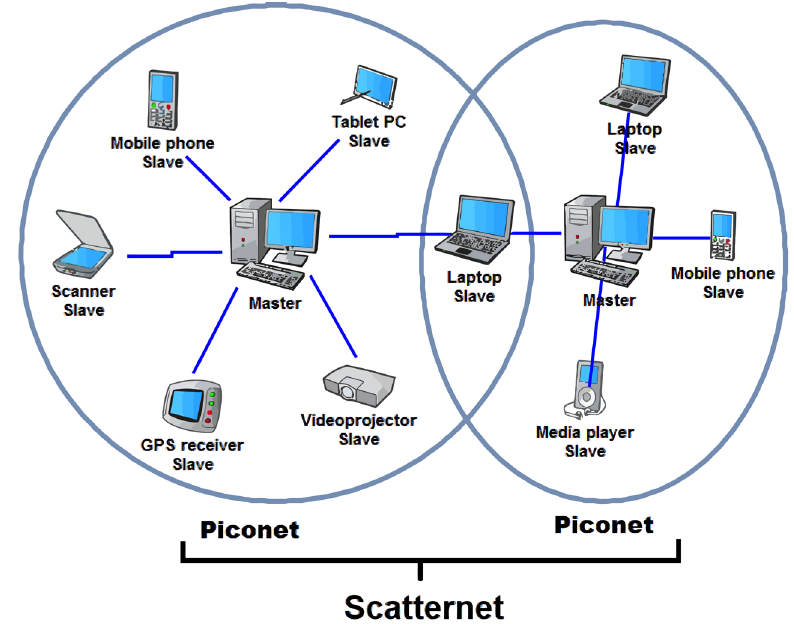
Figure 3. Bluetooth Scatternet and Piconet Hybrid Network